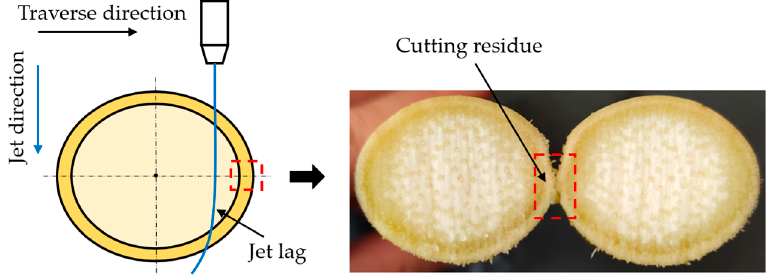
Figure 11. The phenomenon of cu tt ing residue.